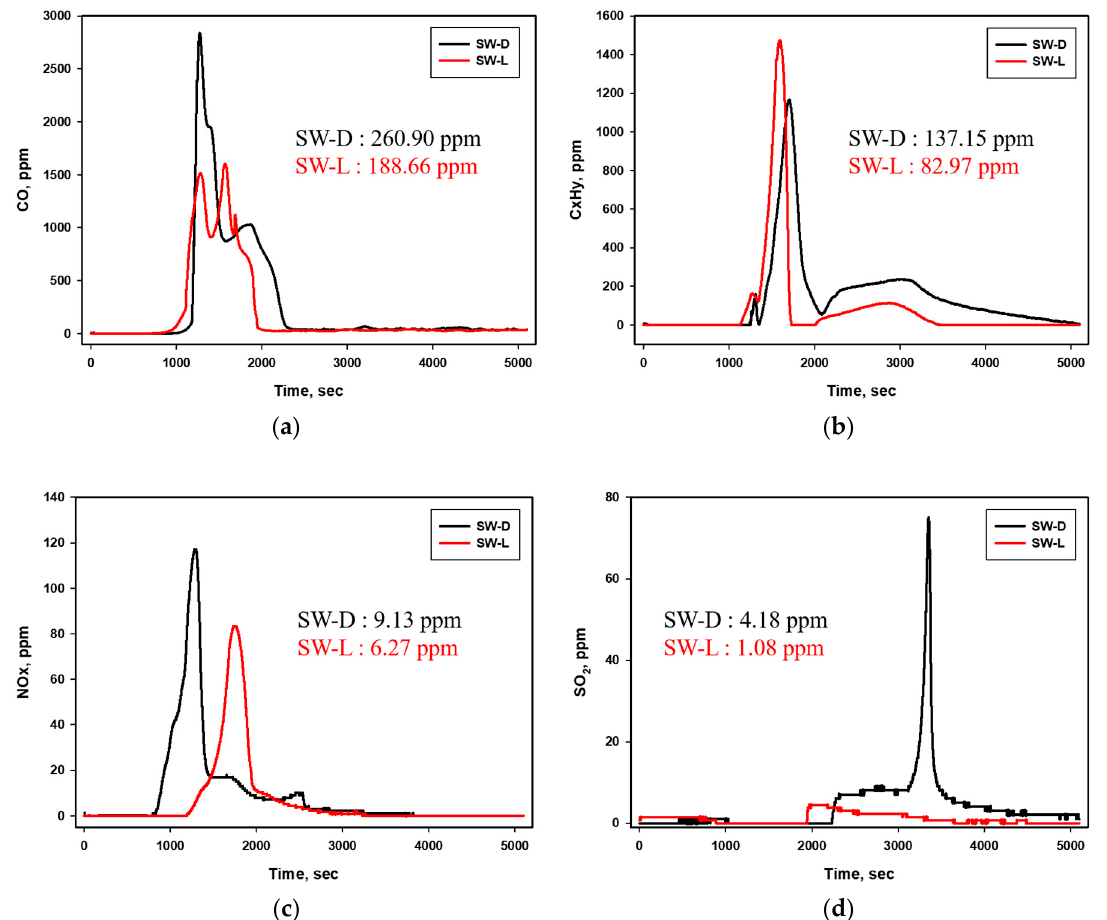
Figure 4. Flue gas emissions of SW-D and SW-L-10: ( a ) CO gas, ( b ) CxHy gas, ( c ) NOx, and ( d ) SO 2 .